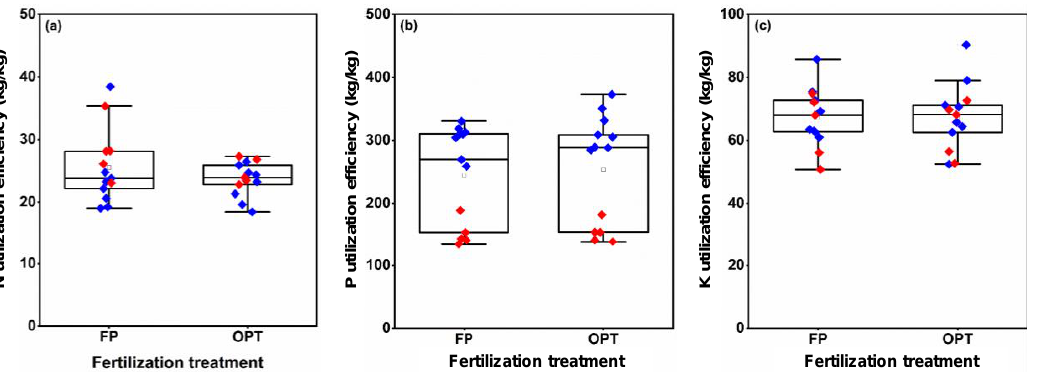
Figure 8. N ( a ), P ( b ), and K utilization efficiency ( c ) of peanuts under different fertilization treatments. FP: farmers’ practice fertilization; OPT: optimized fertilization. For each box plot, the top, middle, and bottom solid lines of the box represent the 75% quantile, 50% quantile, and 25% quantile, respectively; the top and bottom horizontal lines outside the box represent the 90% quantile, and 10% quantile, respectively. The square inside the box represents the mean. Blue or red diamonds: data in 2020 or 2021.